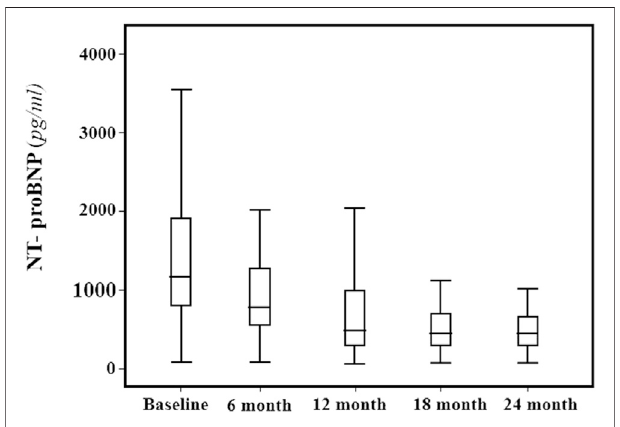
FIGURE 1 | NTproBNP (pg/ml) median and interquartile range values at baseline and every 6 months, during the 24-months follow-up.